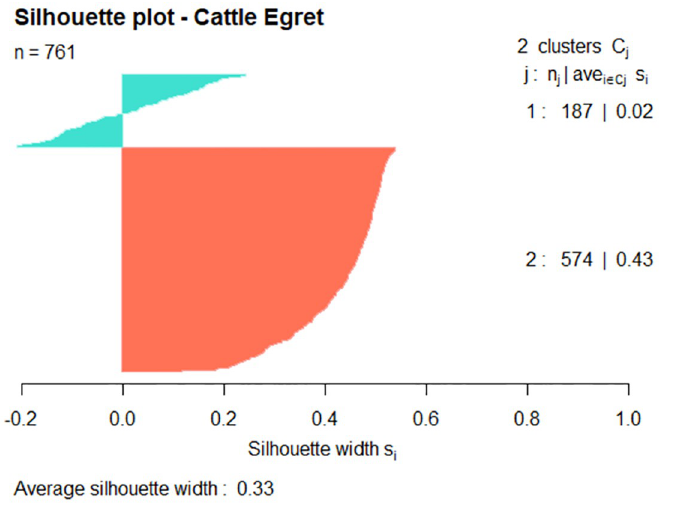
Fig 8. Silhouette plot of Cattle Egret where k = 2.